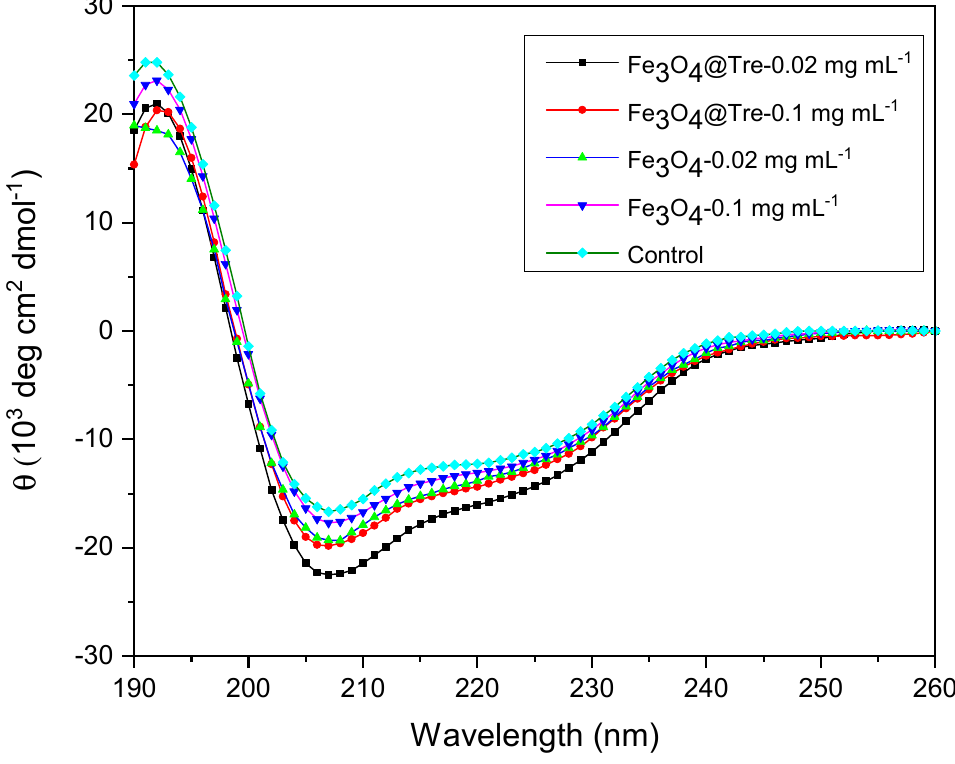
Figure 6. CD spectra of 0.2 mg mL − 1 lysozyme in the presence of Fe 3 O 4 and Fe 3 O 4 @Tre NPs with different concentrations.